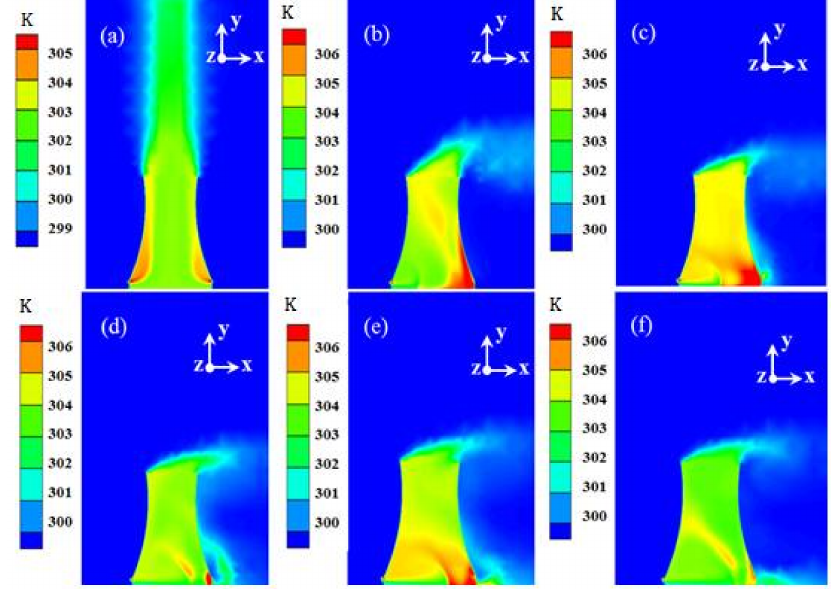
Figure 12. Temperature contour at the center of the mid- xy plane at a wind velocity of ( a ) 0 m/s, ( b ) 3 m/s, ( c ) 4 m/s, ( d ) 5 m/s, ( e ) 6 m/s, and ( f ) 7